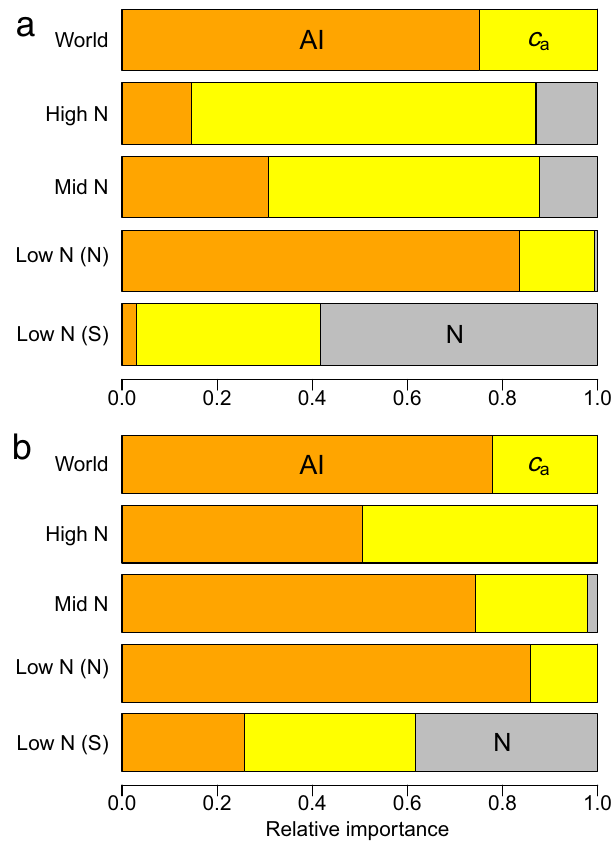
Fig. 4 Proportional contributions to variance due to fi xed effects in multivariate models (see Table 2) of W ( µ mol mol − 1 ) based on atmospheric CO 2 ( c a , µ mol mol − 1 ), aridity index (mm mm − 1 ), and cumulative nitrogen deposition (g N m − 2 20 years − 1 ), for the period 1965 – 2015. Climatic parameters were derived from a TerraClimate database and b CRU